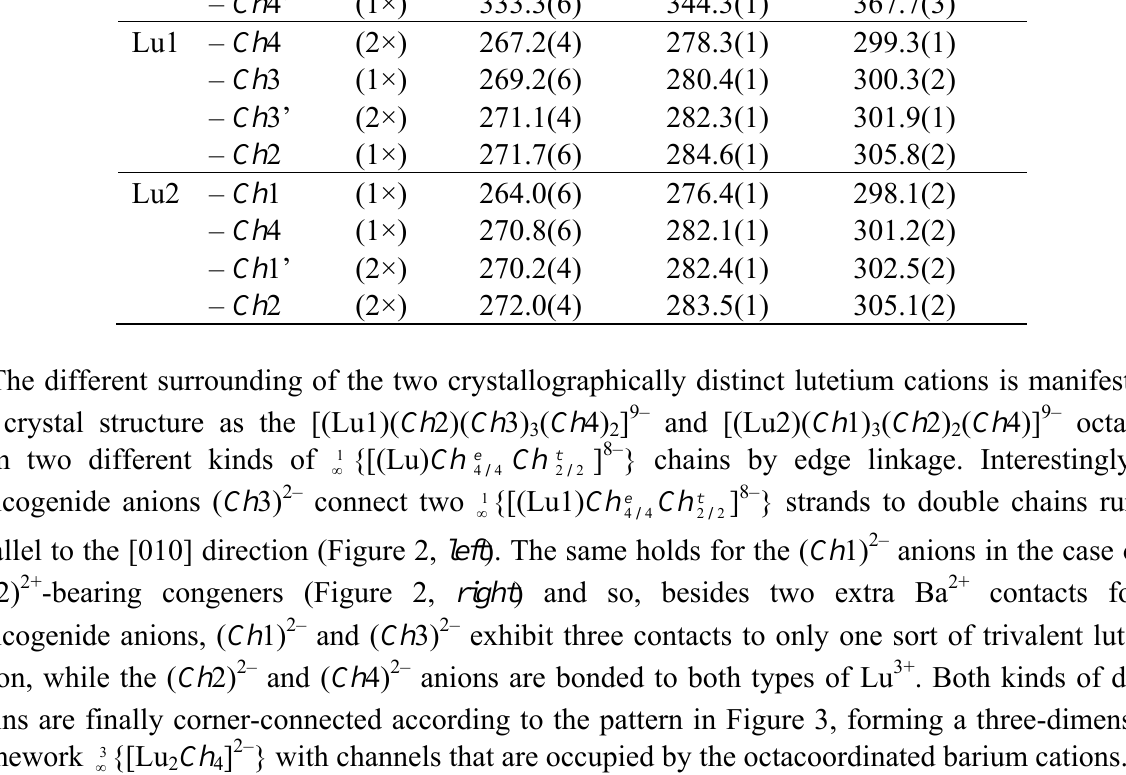
Ch representatives 2 4